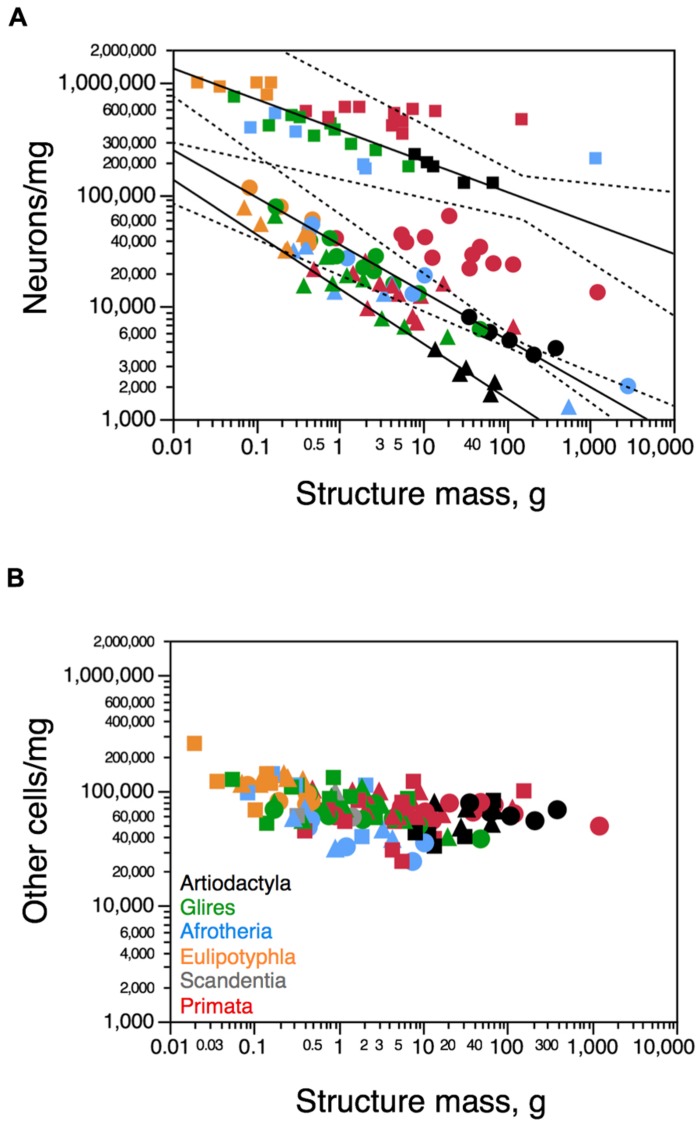
Cellular density variation across structures and species. (A) Average neuronal density (in number of neurons per mg of tissue) in each structure and species. (B) Average density of other cells (in number of other, non-neuronal cells per mg of tissue) in each structure and each species. Both graphs are plotted on a similar Y-axis for comparison. For clarity, only the significant power functions for Artiodactyla are plotted (cerebral cortex with hippocampus, exponent -0.424 ± 0.028; cerebellum, exponent -0.276 ± 0.063; rest of brain, -0.488 ± 0.113). No brain structure in any mammalian order examined here exhibits a significant correlation between other cell density and structure mass. Notice in (A) that the function for neuronal densities in artiodactyl cerebral cortex (minus the giraffe; circles) includes glires, afrotherians and eulipotyphlans, while the function for artiodactyl cerebellum (with the giraffe; squares) includes all other non-primate mammalian clades. Artiodactyl species in black, primates in red, glires in green, afrotherians in blue, insectivores in orange, scandentia in gray. Data from Herculano-Houzel et al. (2006, 2007, 2011), Azevedo et al. (2009), Sarko et al. (2009), Gabi et al. (2010), and Neves et al. (2014).